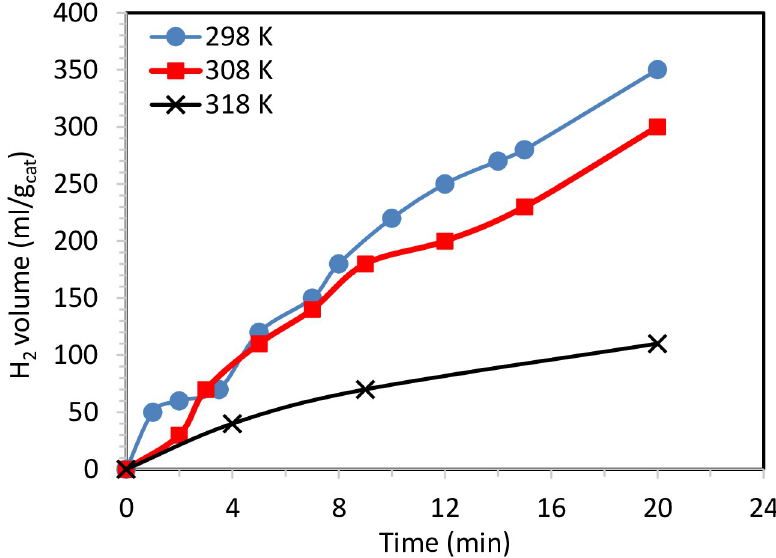
Fig 7. Effect of temperature on hydrogen production from water using (0.05 g) of 0.5 wt % CdTiO 3 -TiO 2